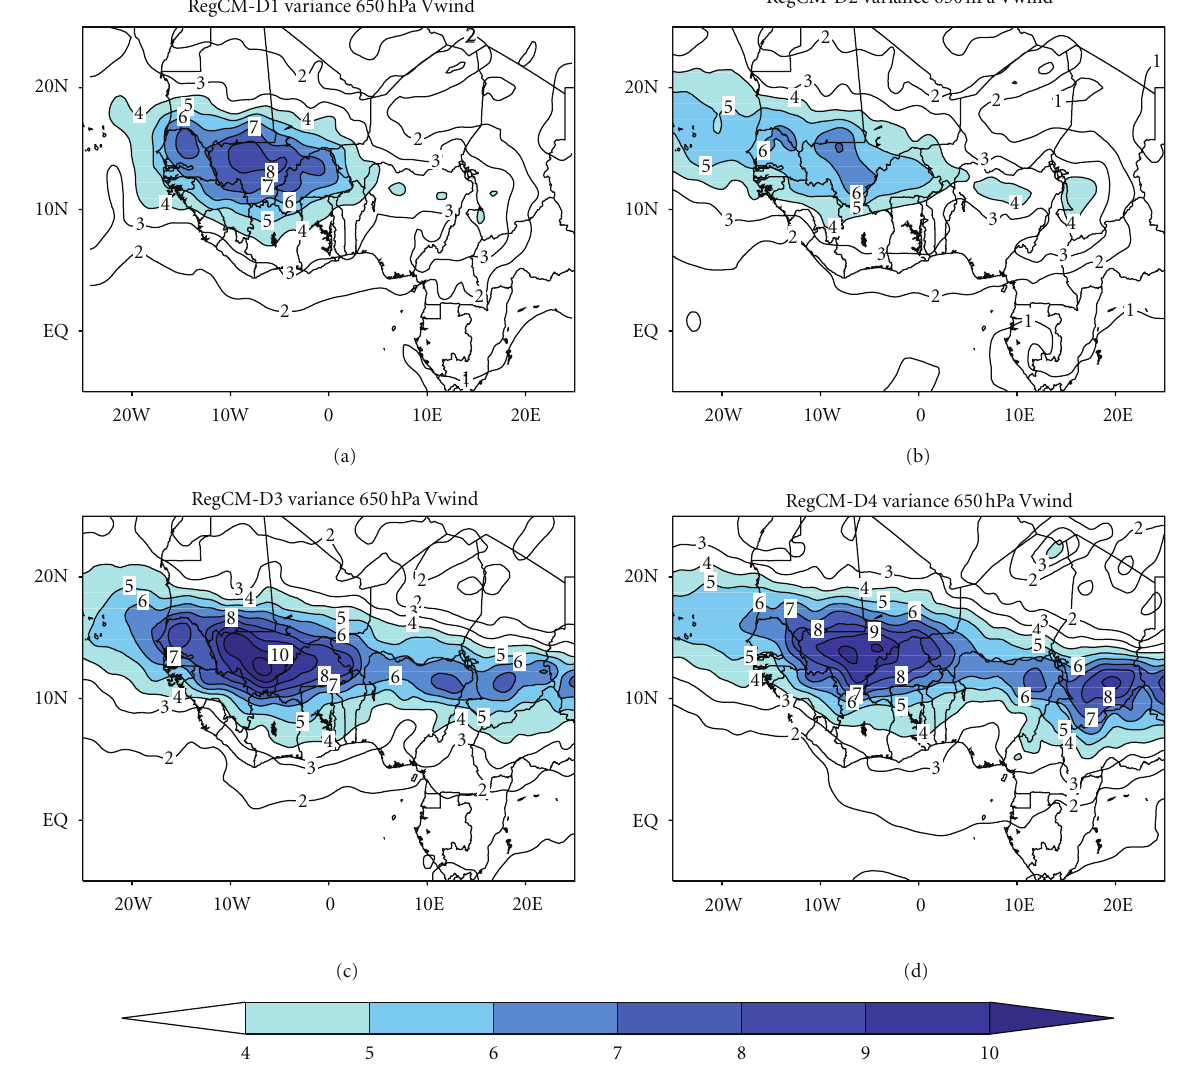
Figure 12: Mean variance of the 3–5 days bandpass filtered of the 650 hPa JJA meridional wind for (a) RegCM-D1, (b) RegCM-D2, (c) RegCM-D3, and (d) RegCM-D4. Units are expressed in